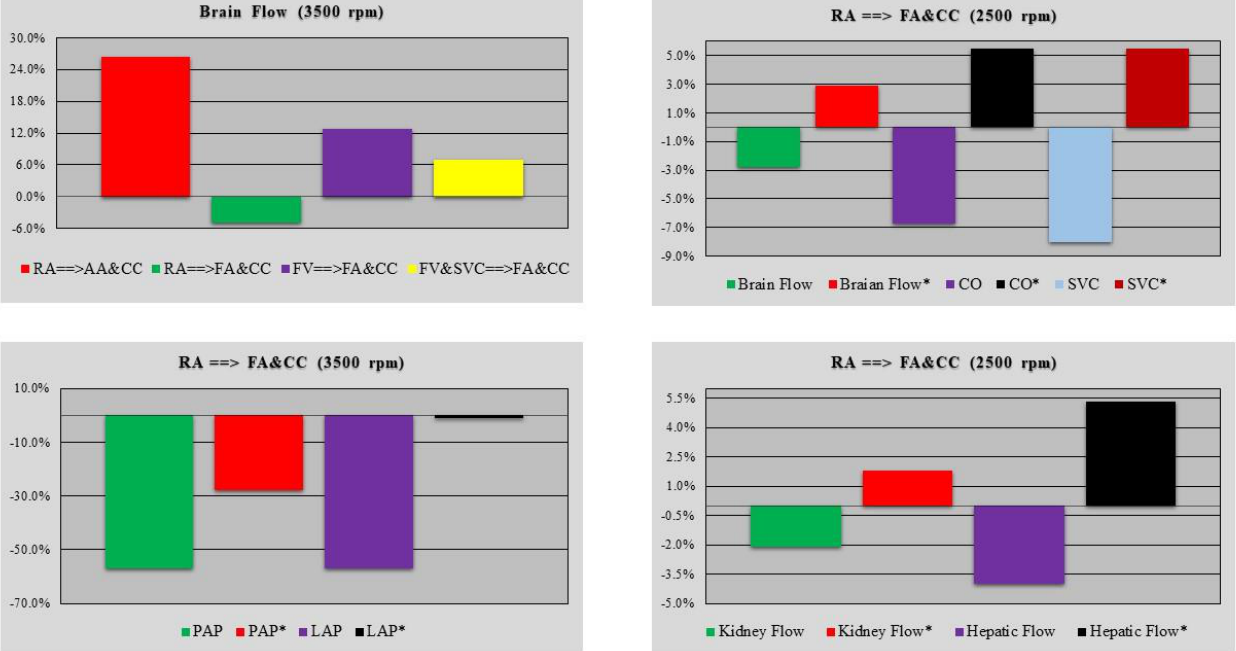
Figure 12. The ( top-left panel ) shows the relative changes in cerebral blood flow induced by three different cannulation configurations with pump rotational speed set to 3500 rpm. The relative changes in cerebral blood flow, superior vena cava flow and cardiac output for RA → FA&CC cannulation with pump speed set to 2500 rpm are available in the ( top-right panel ). Relative changes in CO*, cerebral blood flow* and SVC* blood flow were evaluated when a little increase in ascending aorta resistance was considered during the simulation. Kidney flow*, hepatic flow* ( bottom-right panel ), PAP* and LAP* ( bottom-left panel ) were evaluated in the same conditions when the pump rotational speed was set to 2500 and 3500 rpm, respectively.